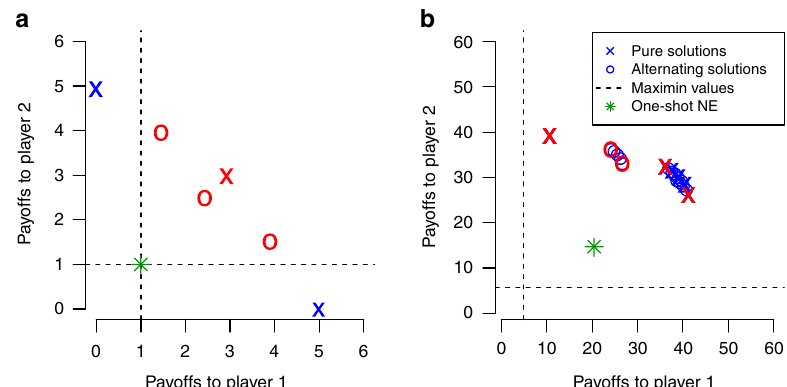
Fig. 9 Target solutions computed by S++. The x ’ s and o ’ s are the joint payoffs of possible target solutions computed by S++. Though games vary widely, the possible target solutions computed by S++ in each game represent a range of different compromises, of varying degrees of fairness, that the two players could possibly agree upon. For example, tradeoffs in solution quality are similar for a a 0-1-3-5 Prisoner ’ s Dilemma and b a more complex micro-grid scenario 44 . Solutions marked in red are selected by S++ as target